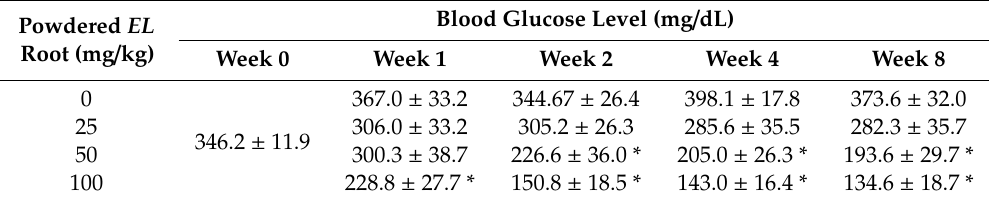
Table 2. Antihyperglycemic activity of powdered E. longifolia root in db / db mice. Powdered